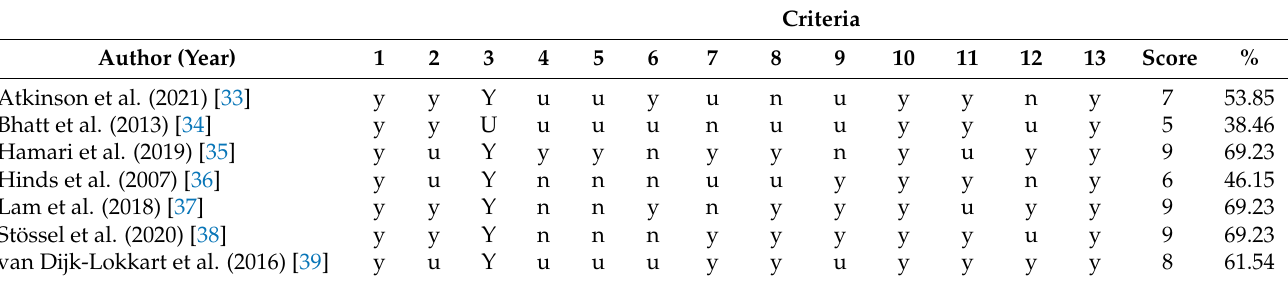
Table 3. Methodological quality of included RCT.